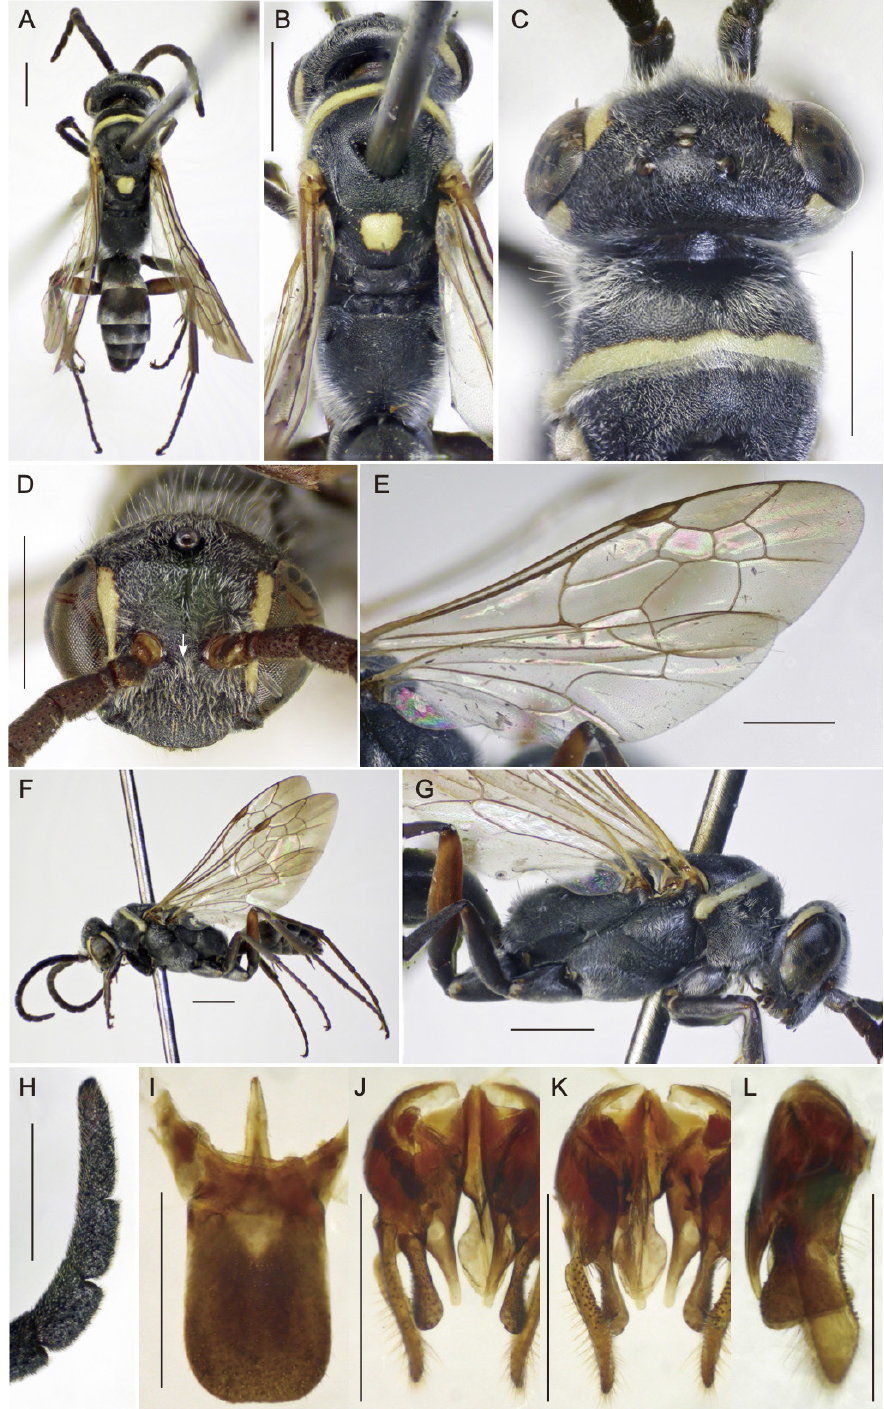
Fig. 5. Ctenocerus srilankae Shimizu sp. nov., paratype, ♂ (NHMUK). A . Whole body, dorsal view. B . Head and mesosoma, dorsoposterior view. C . Head and anterior part of mesosoma, dorsal view. D . Head, anterior view, arrow indicates frontal bridge. E . Left wings. F . Whole body, lateral view. G . Head and mesosoma, lateral view. H . Apical part of right flagellum, lateral view. I . Subgenital plate, ventral view. J . Genitalia, dorsal view. K . Same, ventral view. L . Right side of genitalia. Scale bars: A–G = 1 mm; H–L = 0.5